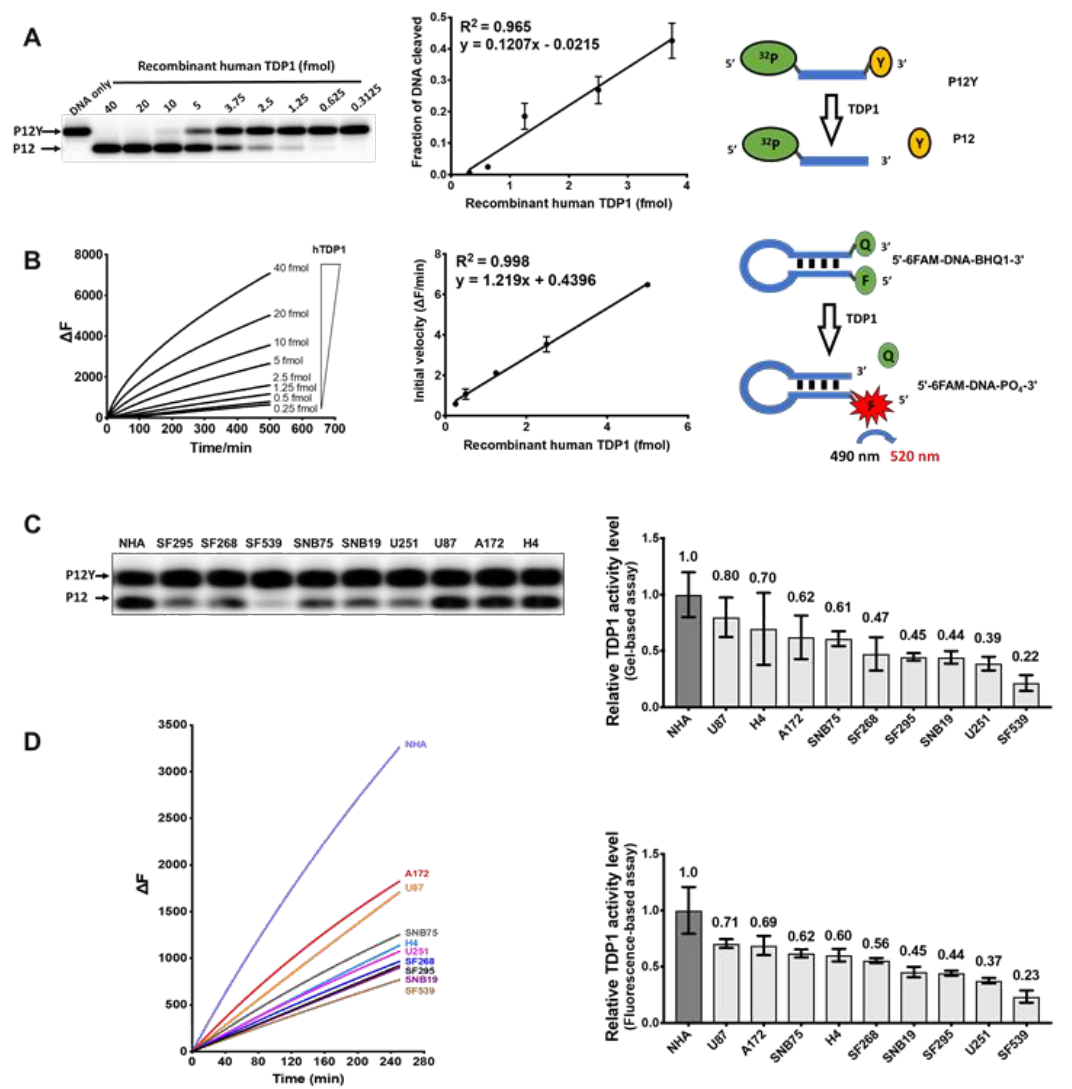
Figure 4. TDP1 activity in GBM cell lines. ( A ) Gel assay for the conversion of radiolabeled P12Y DNA substrate into P12 product by recombinant human TDP1. The standard curve for the fraction of DNA substrate cleaved by increasing amounts of TDP1 is shown on the right; ( B ) TDP1 3’ endonuclease activity on hairpin substrate with 5’ fluorophore and 3’ quencher leads to increase in fluorescence. The initial velocity of fluorescence increase was used to generate a standard curve; ( C ) gel-based assay of relative TDP1 activity levels in GBM WCEs; ( D ) fluorescence-based assay of relative TDP1 activity levels in GBM WCEs. The bar graphs show the average and standard deviation as the error bar (n = 3 or more).